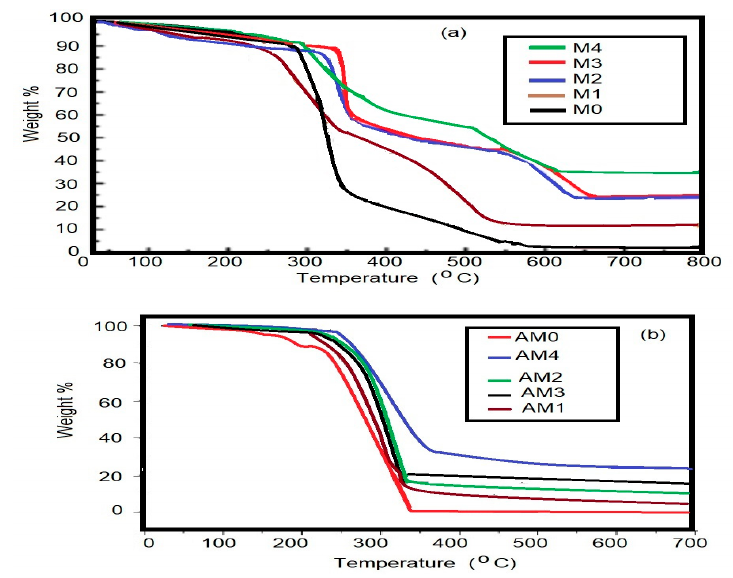
Figure 3. TGA thermograms of ( a ) M and ( b ) AM polymers.